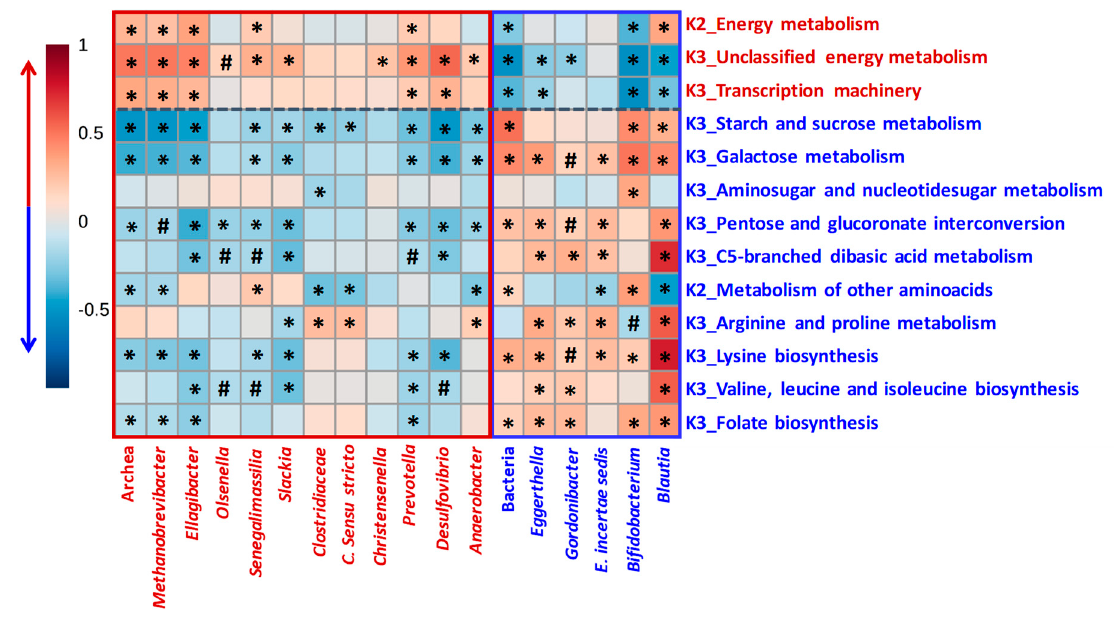
Figure 5. Spearman’s correlations heatmap between specific microbial groups and microbiota functions through postpartum. * : Spearman’s correlation values at p < 0.05 and # : 0.05 > p > 0.1. Microbial groups and functions augmented in UM-B (red color) and UM-A (blue color) were included. The strongest positive (r = 1) and negative correlations (r = − 1) are indicated in red and blue, respectively.